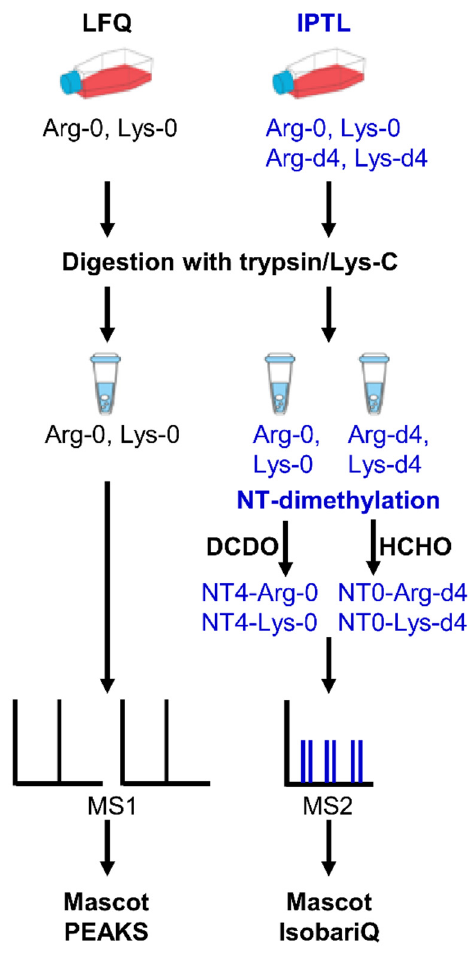
Figure 1. Workflow for the comparison of LFQ and IPTL.